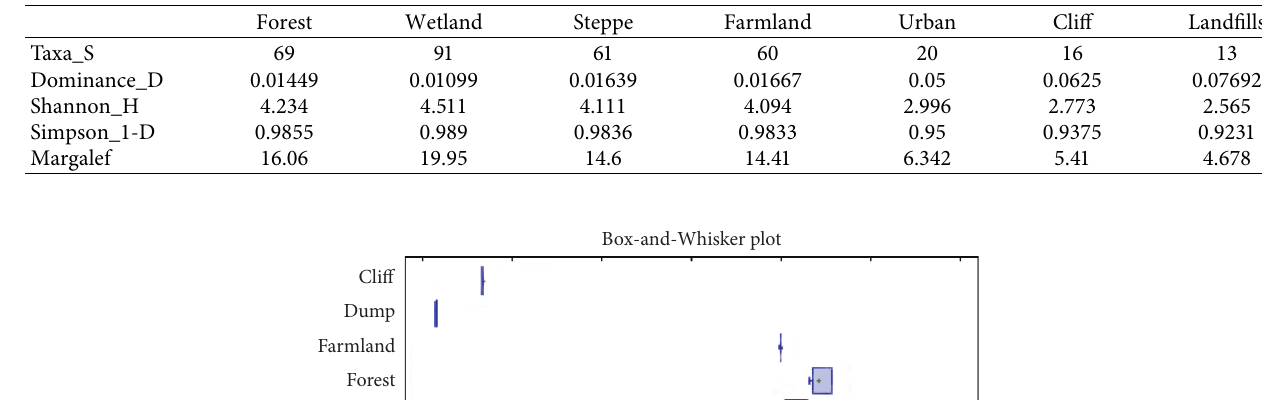
Table 5: Avian diversity among studied habitats in Midelt